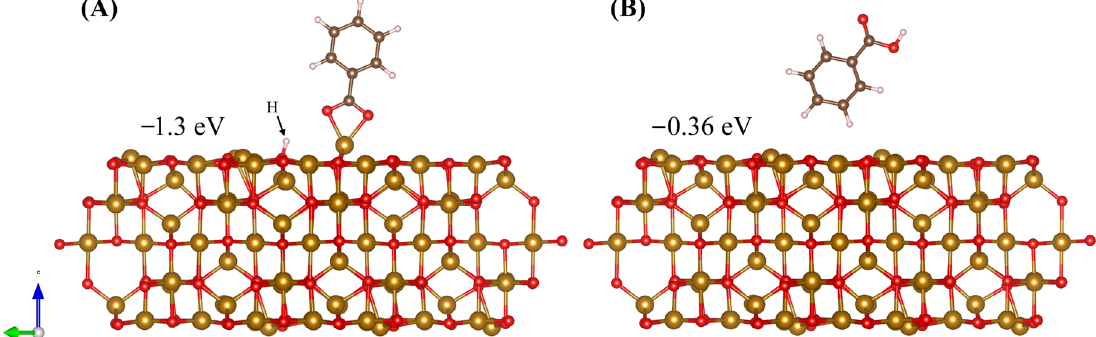
Figure 10. Adsorption of BA in two different configurations, ( A ) chelating bidentate via carboxyl groups, and ( B ) bonding of H to Fe 3 O 4 surface O atoms. The adsorption can be accompanied by the surface adsorption of H + ions displaced from OH groups.